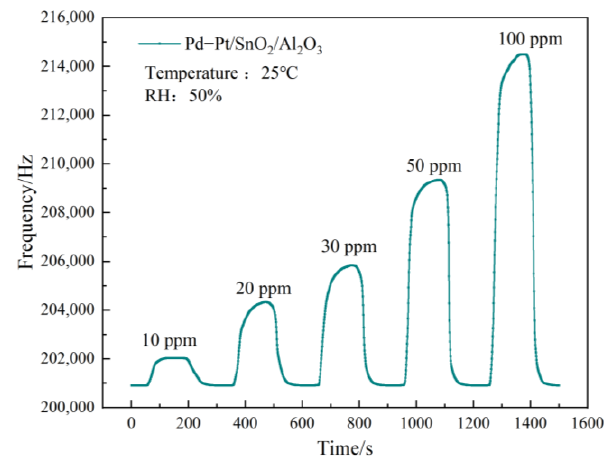
Figure 7. Dynamic response of different CO concentrations of SAW sensors.